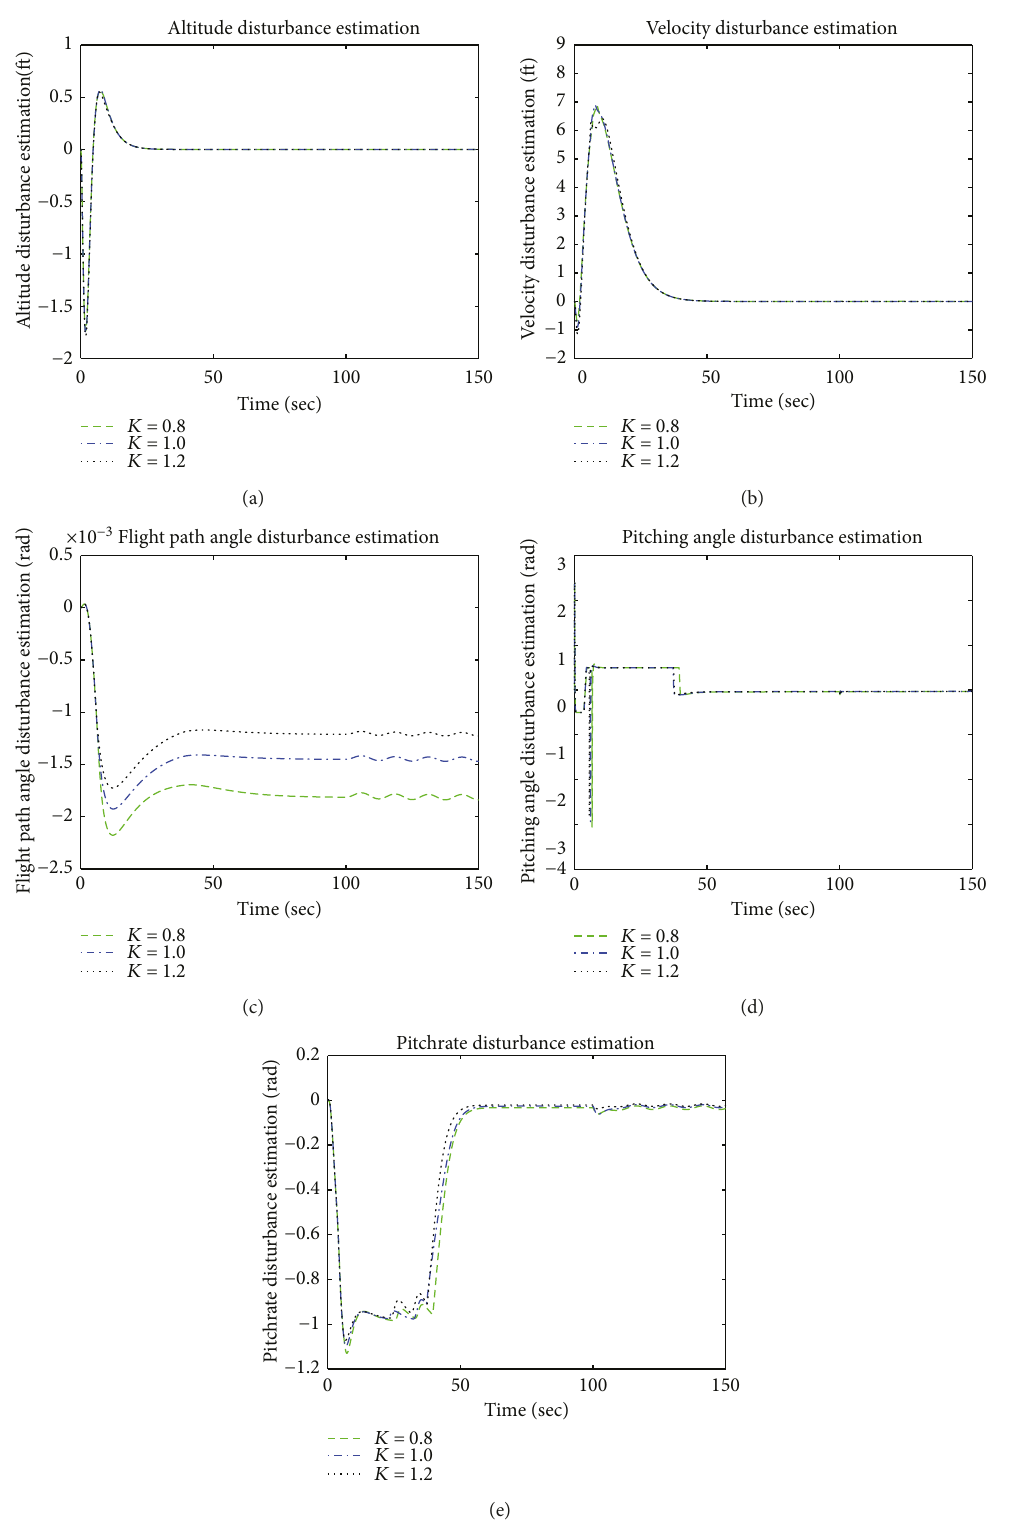
Figure 10: Lumped disturbance estimated by nonlinear disturbance observer. The parameters de fl ection, uncertainty terms, and external disturbance are added into the